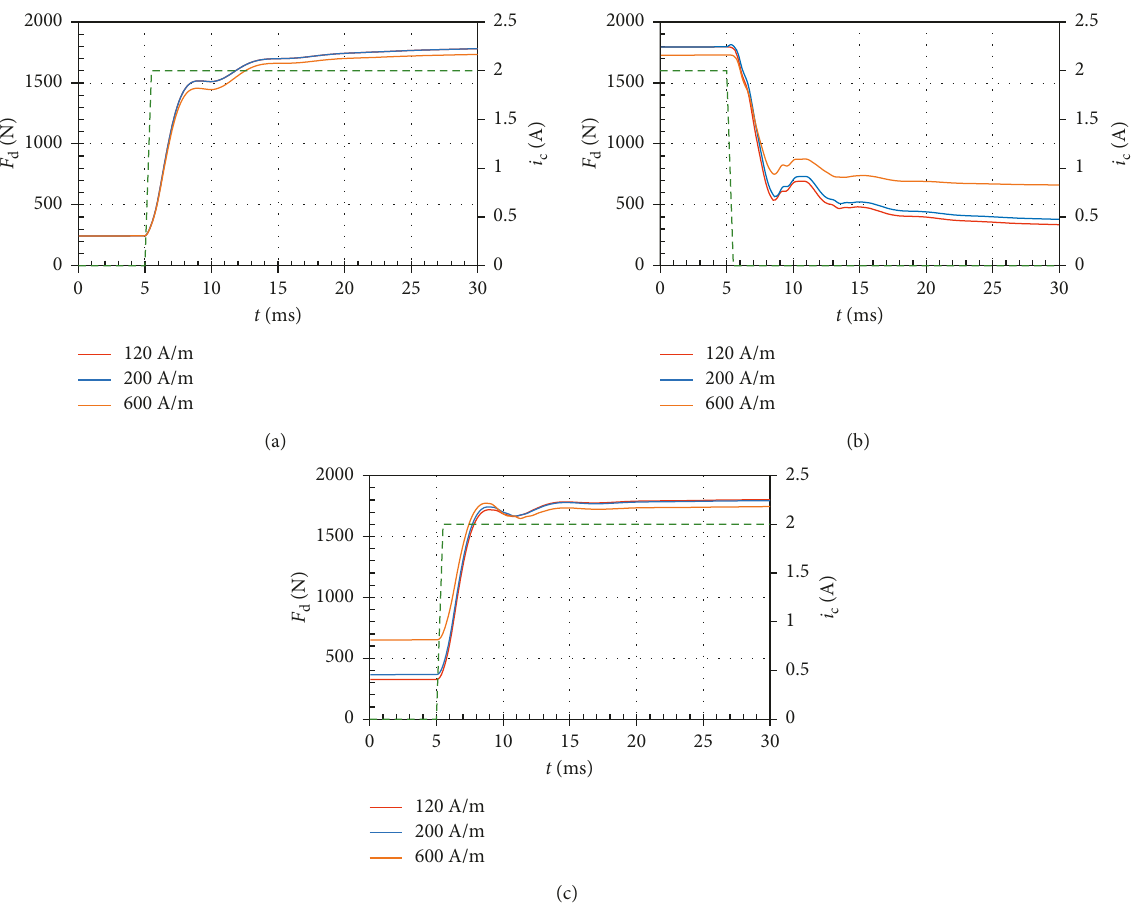
Figure 28: Impact of the coercivity H c . Full line: damping force time history; green dashed line: current step input. (a) Force vs time: current rise (initial condition � demag.). (b) Force vs time: current drop. (c) Force vs time: current rise (no demag.).